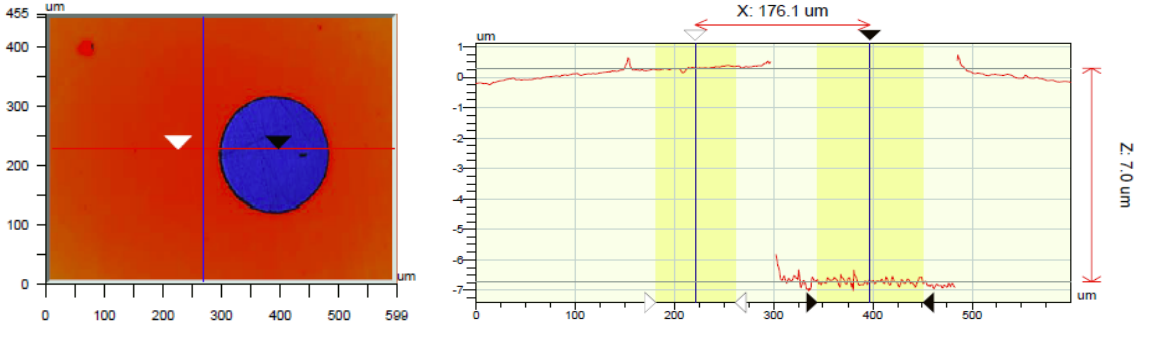
Figure 6. Optical profile measurement showing a gelatin layer thickness of 7 µm. The gelatin was removed locally using an Excimer